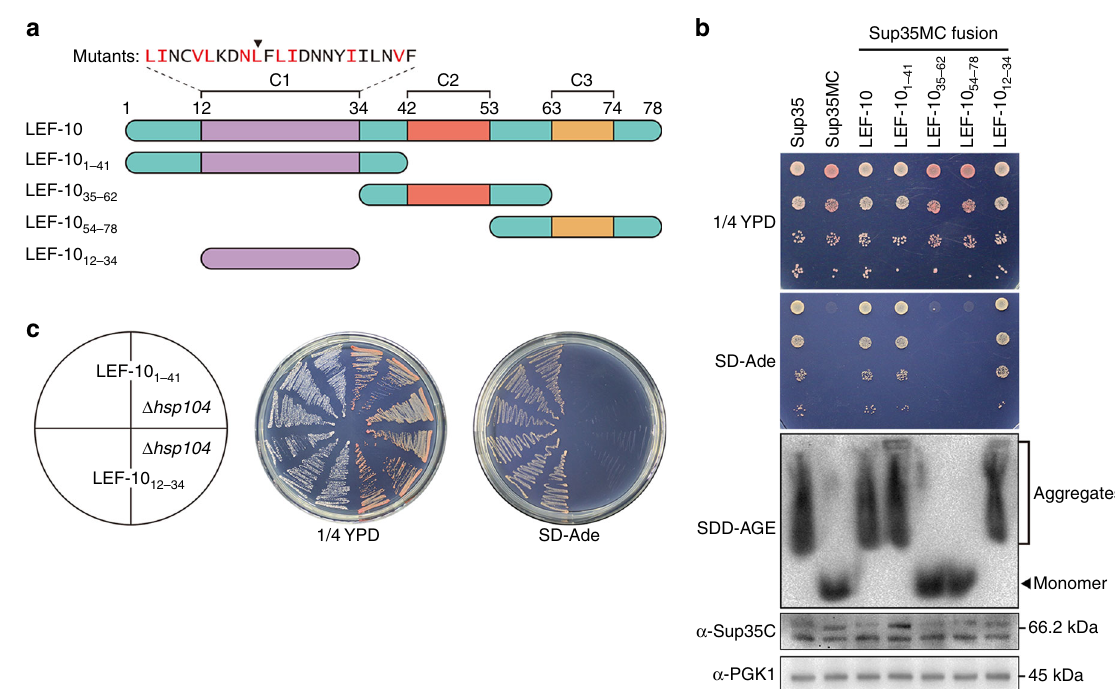
Fig. 4 Identi fi cation of a candidate prion-forming domain (cPrD) in LEF-10. a Cartoon of LEF-10 and its truncations. The location of three conserved regions (C1, C2 and C3) and the amino acid sequence of the predicted cPrD are presented above. The ten highly conserved amino acids in C1 are colored in red. L21 is indicated by the inverted triangle. b Characterization of LEF-10 truncations in yeast. LEF-10, LEF-10 1-41 and LEF-10 12-34 display similar characters to Sup35 on 1/4 YPD and SD-Ade medium, and by SDD-AGE. Western blot detected all the truncated LEF-10-Sup35MC expressing at similar levels as full-length Sup35. PGK1 was measured as the loading control. Strains with Sup35 and Sup35MC were used as positive and negative controls. c The [ LEF + ] phenotype of LEF-10 1-41 and LEF-10 12-34 is curable by deletion of the HSP104